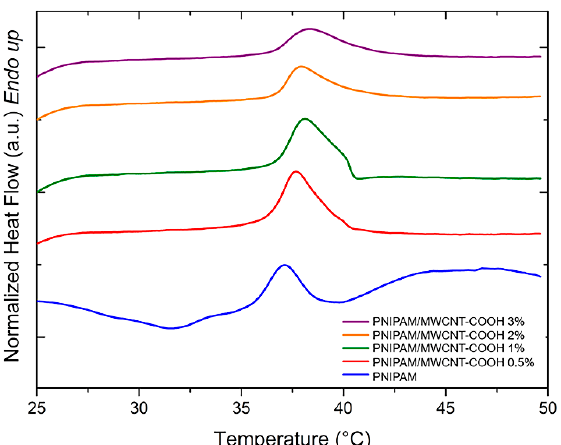
Figure 7. DSC curves (heating rate 10 °C/min) for determination of volume phase transition peak of PNIPAM/MWCNT-COOH hydrogels at different filler concentrations hydrated in pure water.